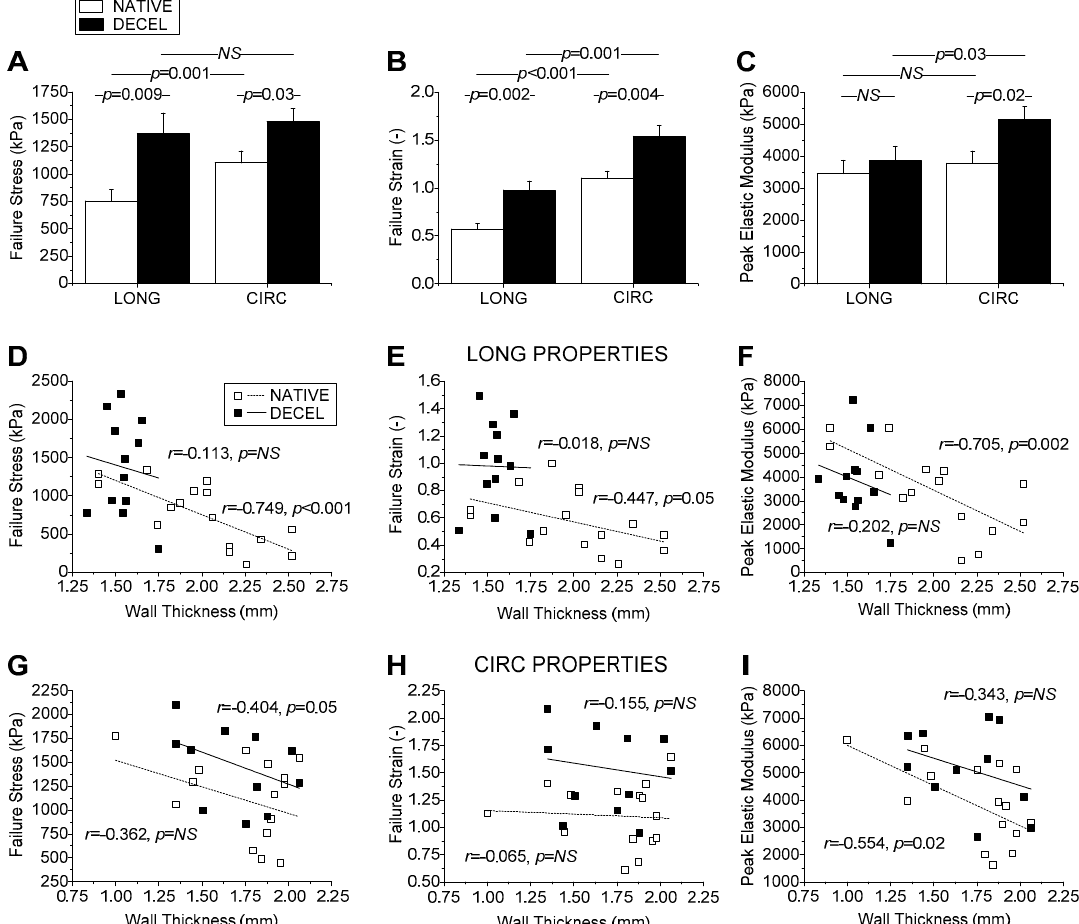
Figure 6. Uniaxial biomechanical testing of hUAs. Failure stress ( A ), failure strain ( B ), and peak elastic modulus ( C ) of native and decellularized hUAs. Correlation of failure stress ( D ), failure strain ( E ), and peak elastic modulus ( F ) with wall thickness in a longitudinal direction. Correlation of failure stress ( G ), failure strain ( H ), and peak elastic modulus ( I ) with wall thickness in a circumferential direction.